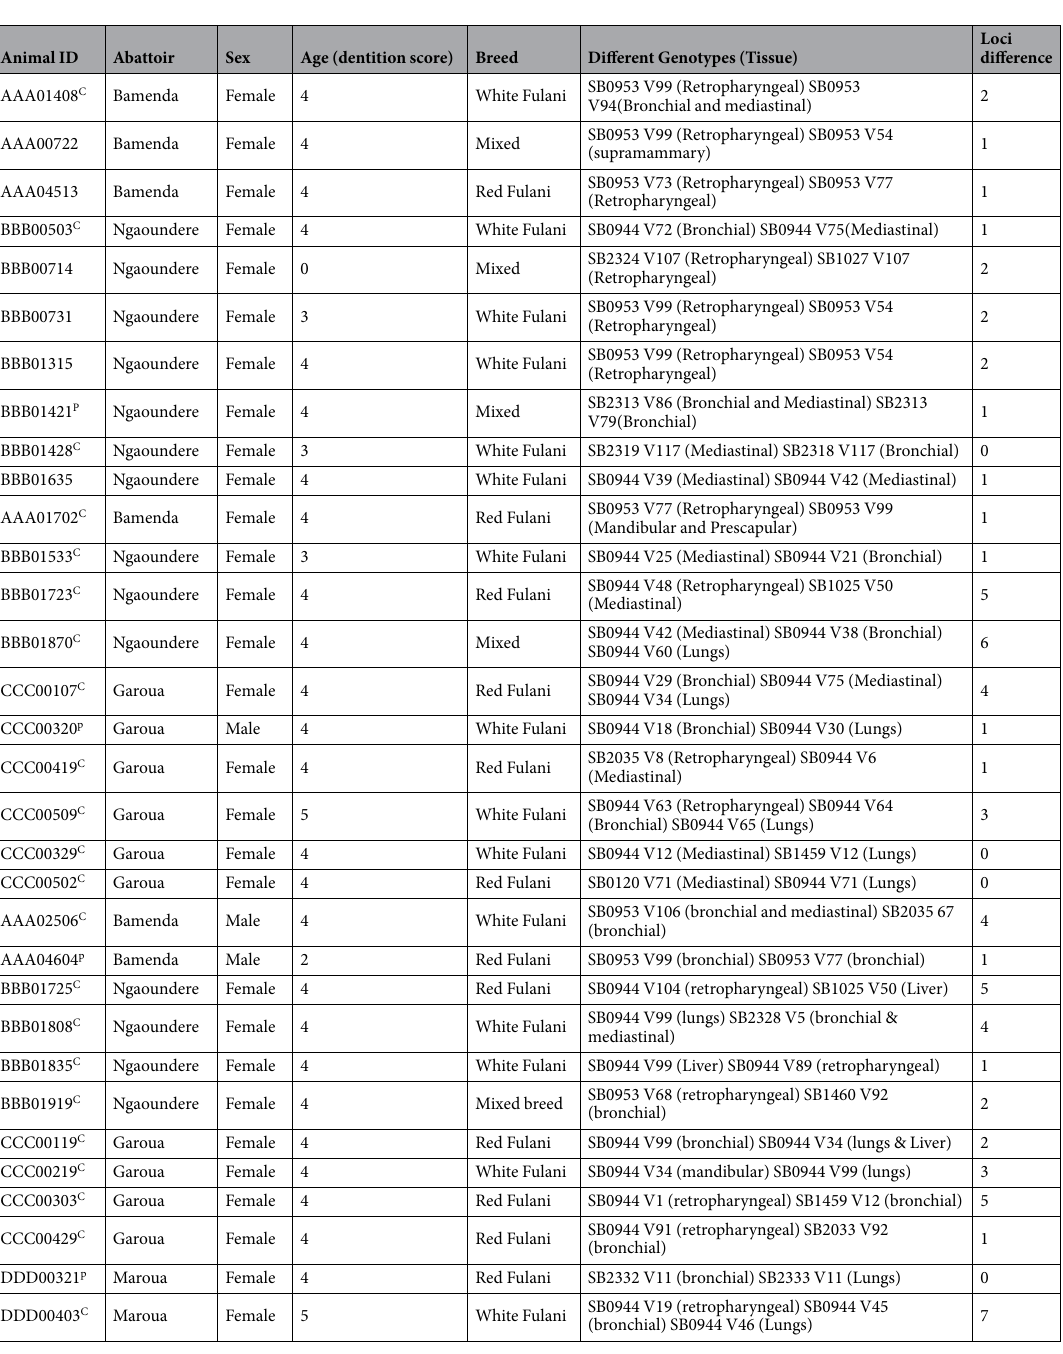
Table 3. Presence of multiple M. bovis strain infections from cattle from four abattoirs in Cameroon sampled between 2012–1013. P Pulmonary mixed infection and C Compartmentalized mixed